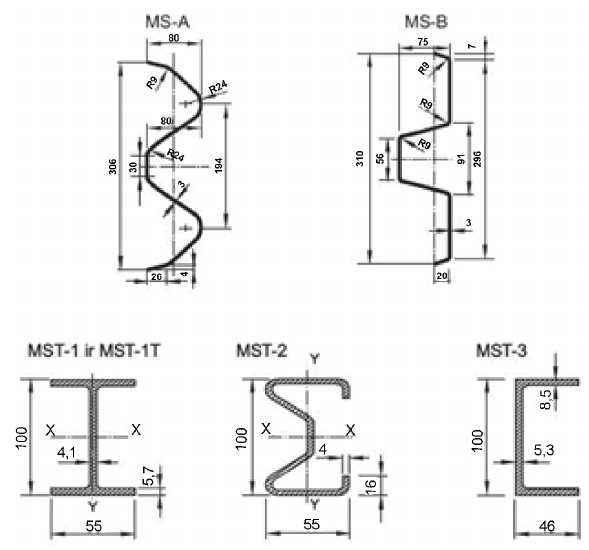
Fig. 8. Cross-sections of metal beams and posts (R37-1 2001)